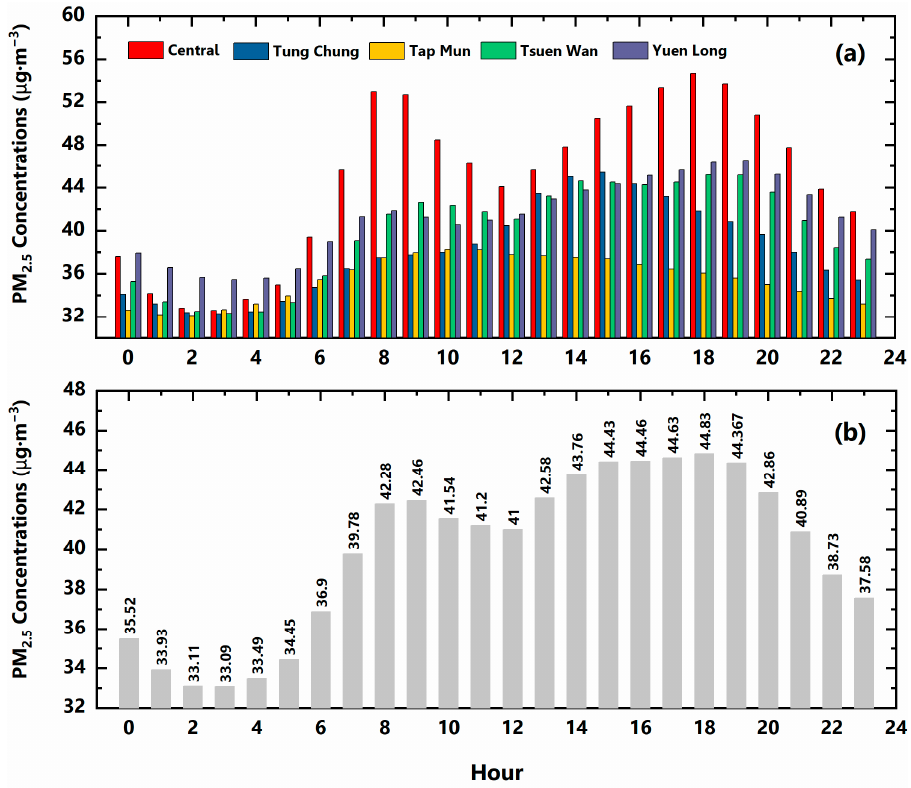
Figure 5. Four-years (2005–2008) of mean PM 2.5 concentrations for daily hours with respect to air quality monitoring stations ( a ) and when all the stations are combined ( b ).